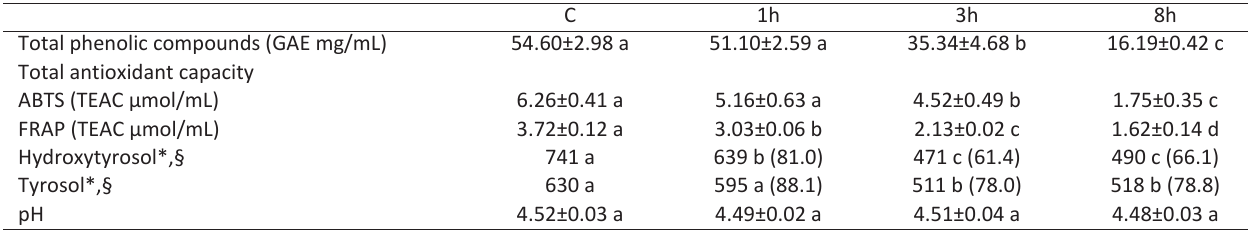
Values in the same row followed by different letters differ significantly (significance was set at P<0.05). * Arbitrary unit. § % residual inside the round brackets.